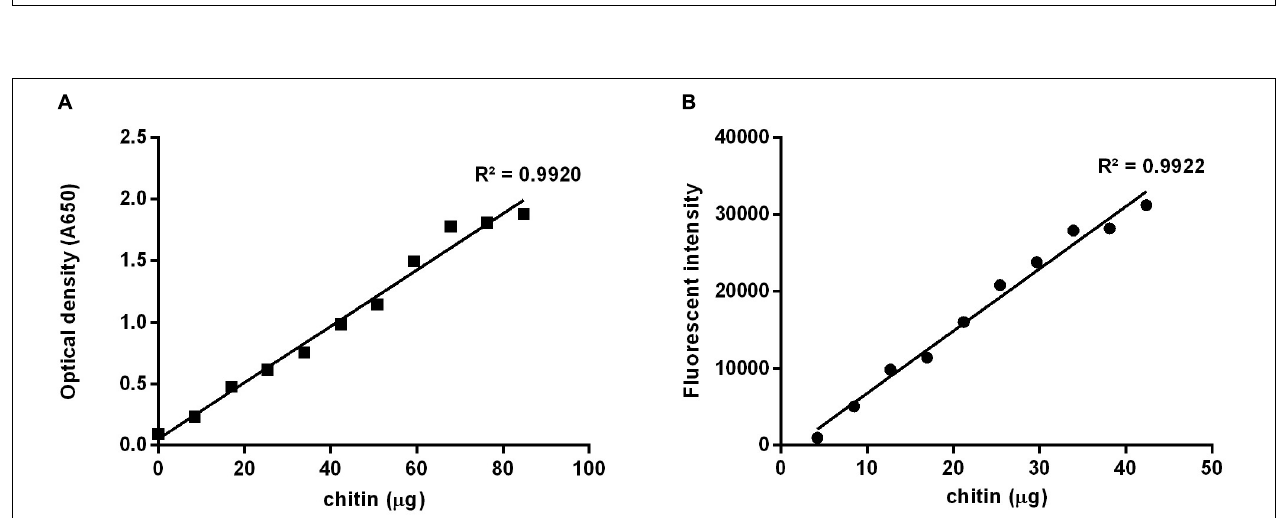
FIGURE 2 | Standard curves prepared using increasing masses of colloidal chitin suspension at 4.24 µ g/ µ L. (A) Based on the method described by Lehmann and White (1975), absorbance at 650 nm; (B) Using calcofluor stained chitin, excitation at λ ex 355 nm and emission at λ em 433 nm.